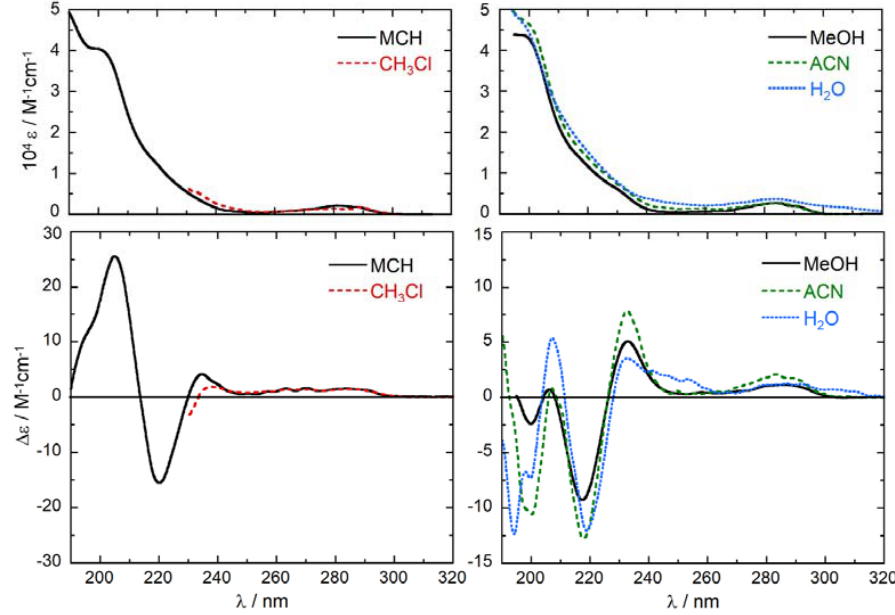
Figure 2. Absorption (top) and ECD spectra (bottom) of ( R ) ‐ tolterodine ( 1 ) measured in different solvents. Concentration 1.67×10 –4 M, cell path length 0.1 cm. solvents. Concentration 1.67 × 10 − 4 M, cell path length 0.1